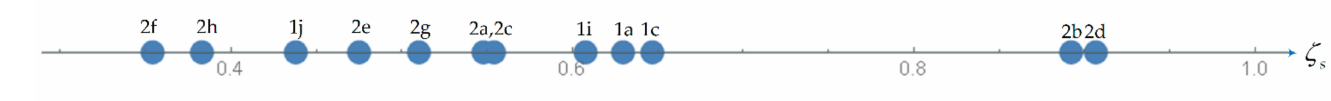
Figure 3. Damping of Short Period mode in oscillatory flight